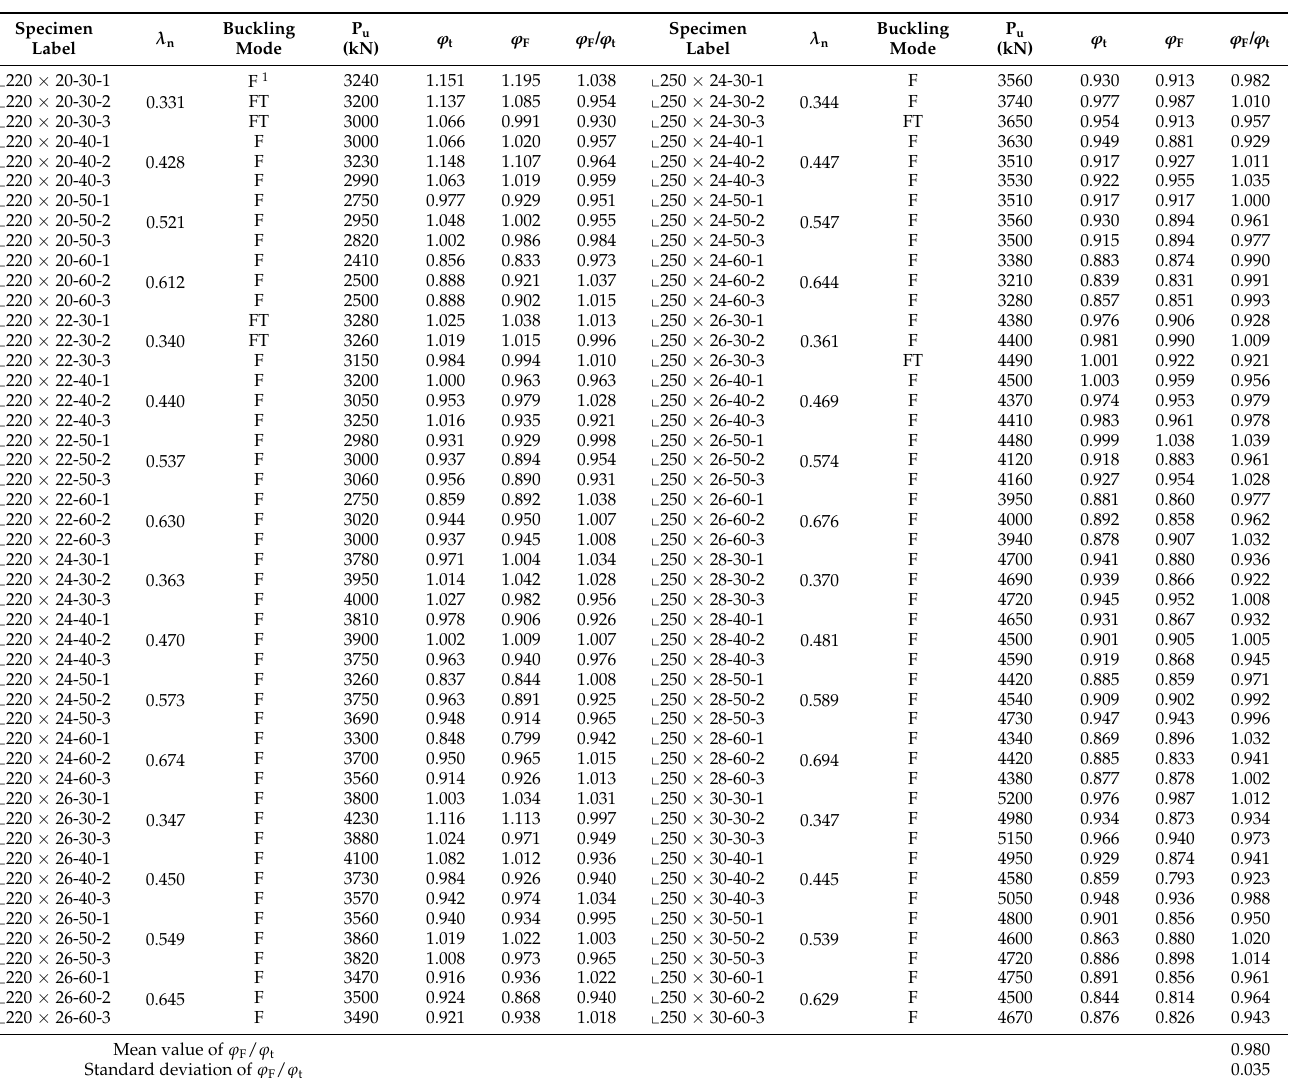
Table 5. Tested results and comparison with FE